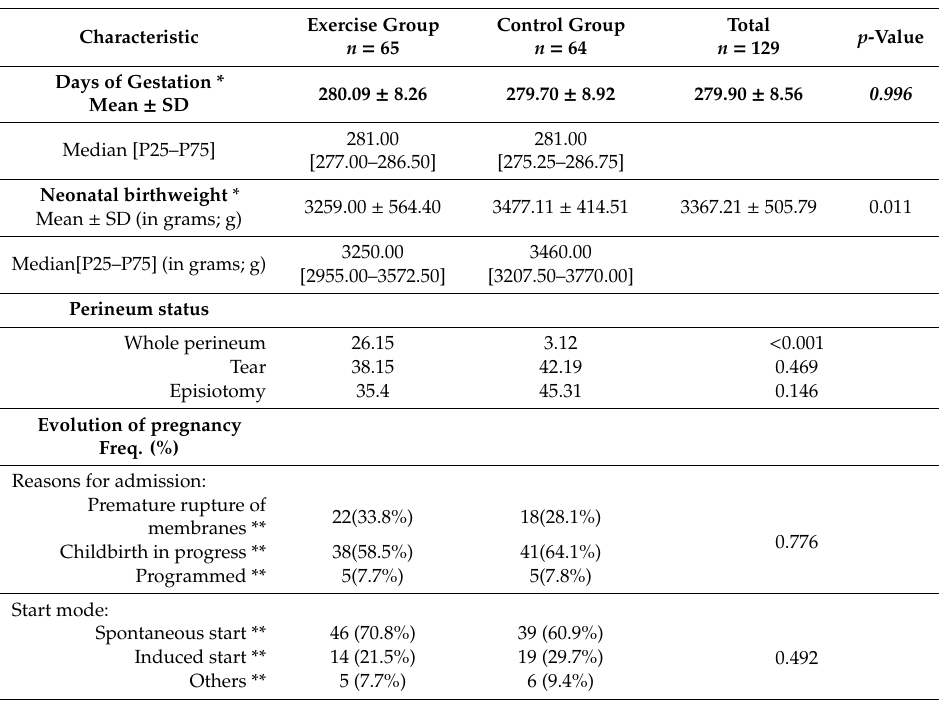
Table 2. Descriptive data of the birth.